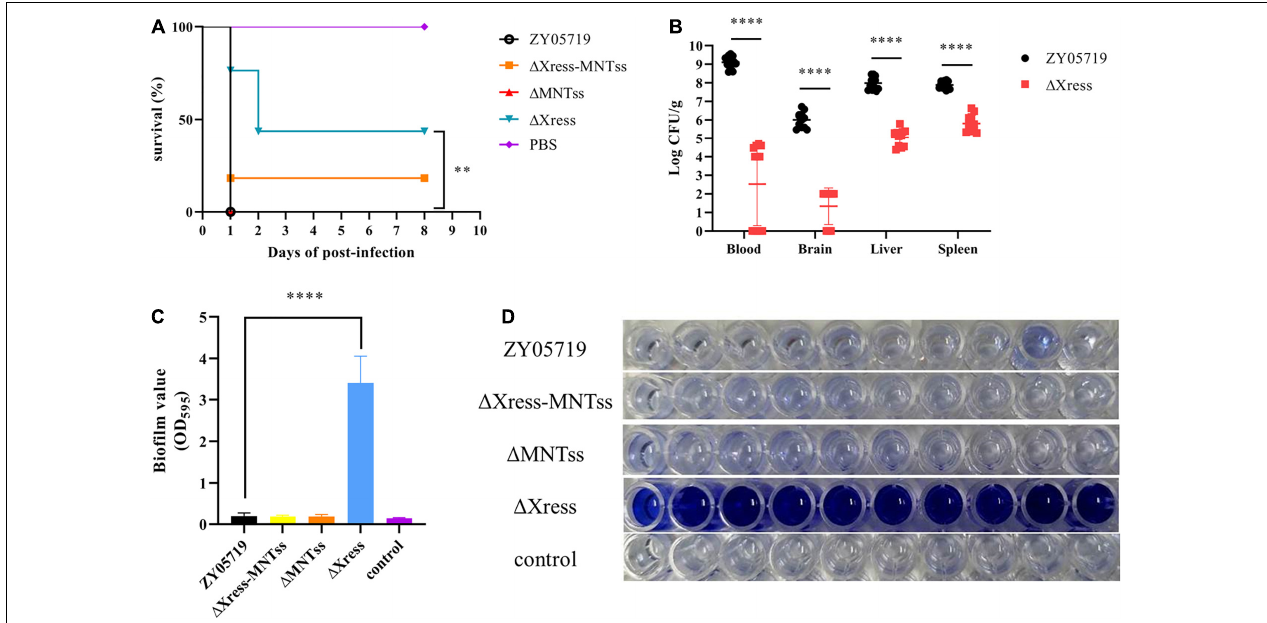
FIGURE 5 | Xress-MNTss contributes to S. suis virulence and affects biofilm formation. (A) Survival curves of 5-week-old BALB/c mice infected with wild-type or mutant strains at 5 × 10 8 CFU/mouse. The control group received only PBS. Ten mice from each group were monitored over a 7-day period. Log-rank (Mantel-Cox) test to determine differences in survival between groups: ∗∗ P < 0.01. (B) Infected mice were euthanized 6 h after infection to determine the bacteria burden in the blood, brain, liver, and spleen. Biofilm formation in panel (C,D) 200 µ l culture medium was inoculated in each well of 96-well plate. Unpaired two-tailed Student’s t -test: ∗∗∗∗ P <